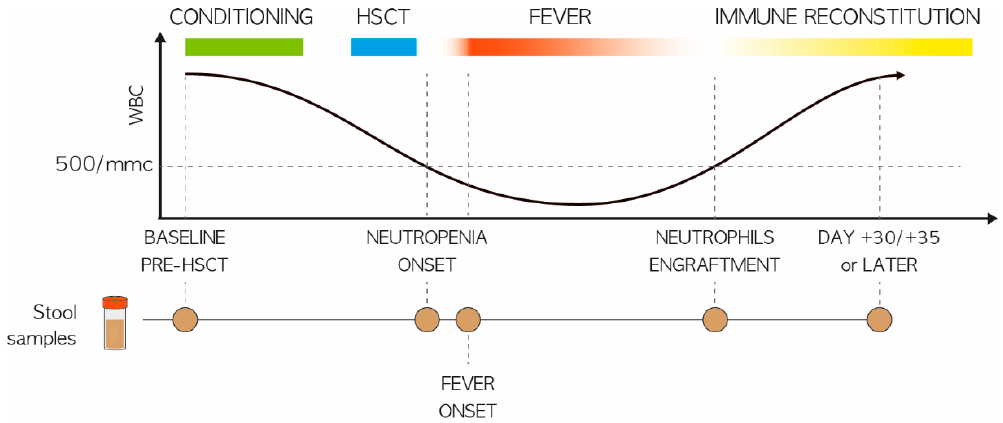
Figure 1. Study design. Schematic representation of fecal sampling for pediatric patients undergoing HSCT, in relation to the development of FN. Circles indicate the sampling timepoints, i.e., at baseline (before transplant; PRE), at the onset of neutropenia (day − 2/+2; P2), at the onset of fever (day +4/+5; P5), at engraftment (TAKE) and after engraftment (day +20/+30; P20). Patients were stratified based on the median of total fever days into two groups: (i) less than or equal to three days ( n = 16) and (ii) more than three days ( n =